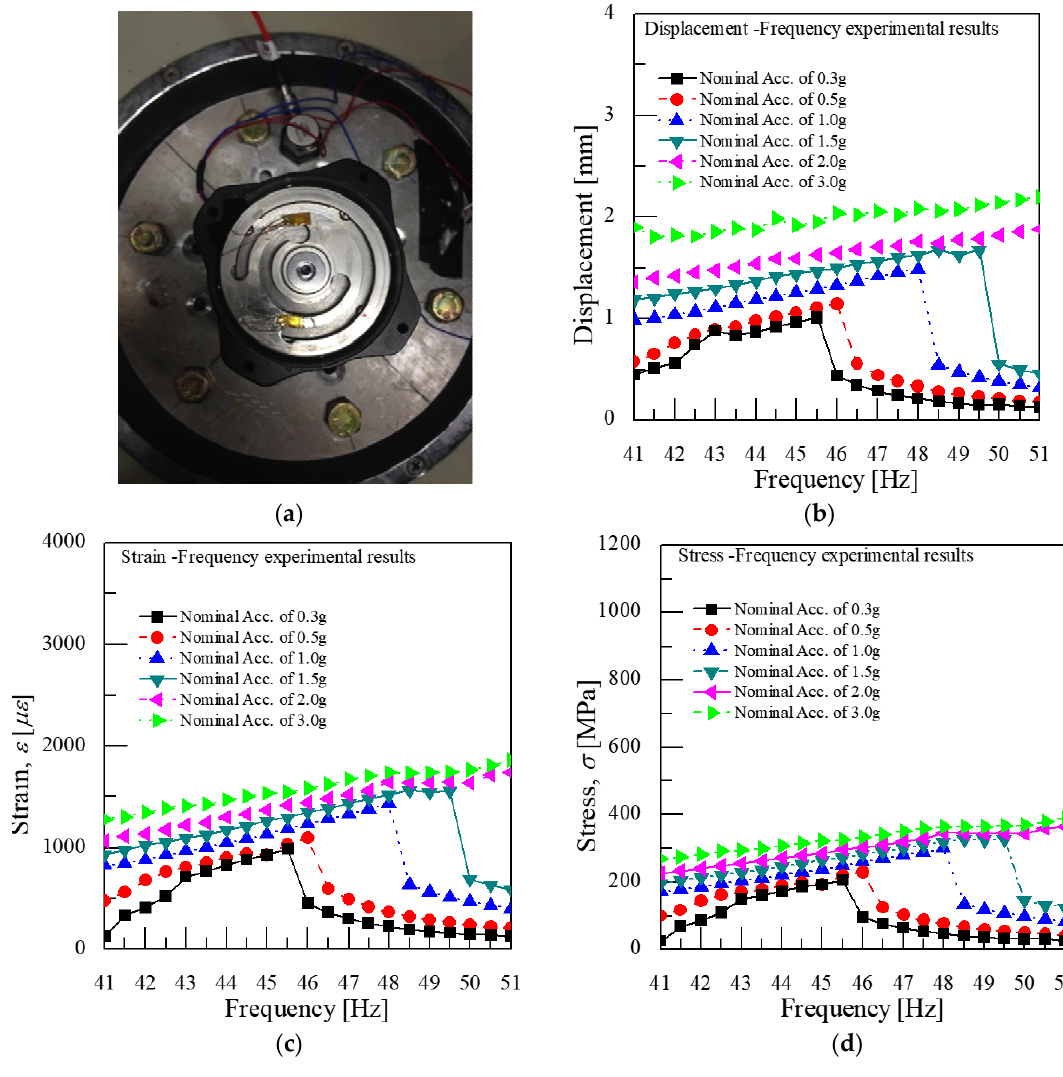
Figure 16. ( a ) The strain gauges on the spring of the VEH device at the stress–strain concentration place; ( b ) the change in both the displacement and the frequency according to the vibration acceleration; ( c ) the change in both the strain and the frequency; ( d ) the change in both the stress and the frequency. The thickness of the spring was 0.7 mm.